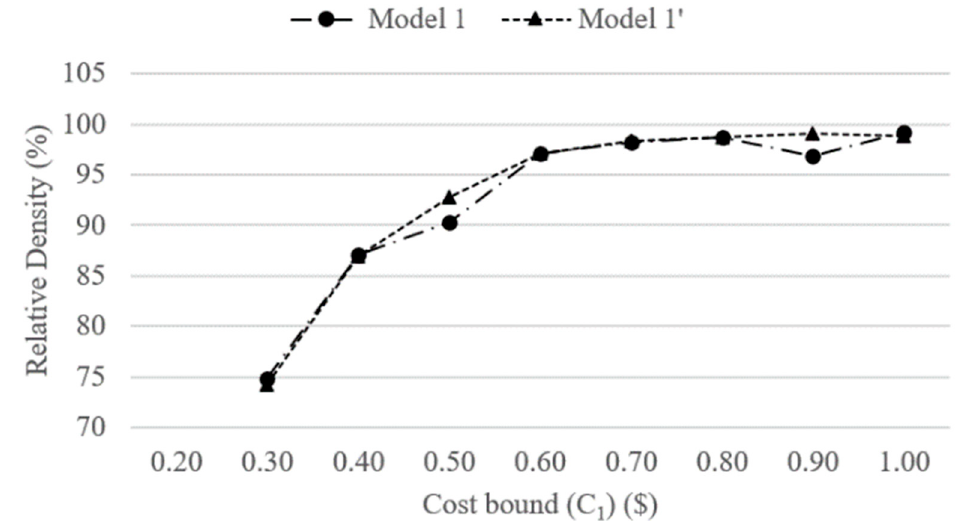
Figure 3. Comparison of variation in relative density with change in cost bound for Model 1 and Model 1 ′ .